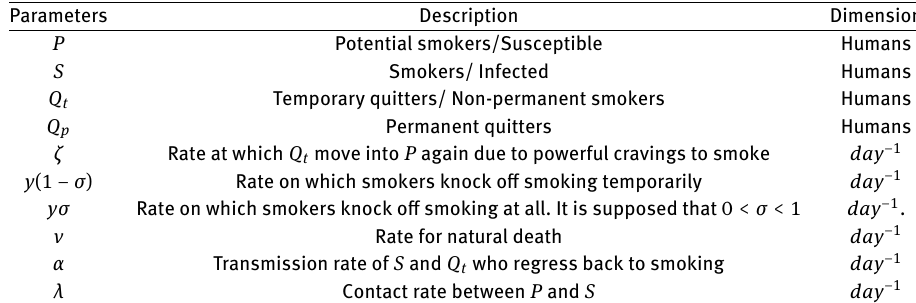
Table 1: List of used Parameters along with State variables Parameters Description Dimension P Potential smokers/Susceptible Humans Smokers/